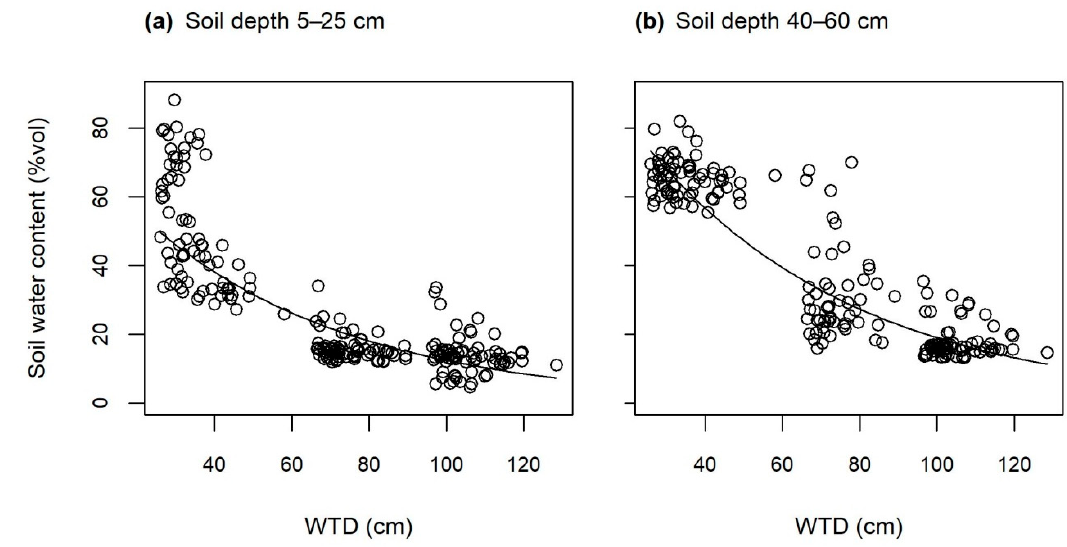
Figure 3. Soil water content in 5–25 cm ( a ) and 40–60 cm ( b ) soil depths depending on water table distance (WTD). Data were collected weekly in the second growing season from May to September 2019 at three positions in each tank (Figure 2). Lines are fitted by mixed effect LM: random effect = tank number ( a ): ln(y) = 4.39 − 0.02 x, p < 0.001, n = 216; ( b ): ln(y) = 4.77 − 0.02 x, p < 0.001, n = 197.